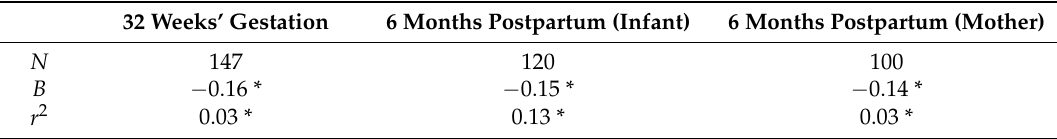
Table 3. Association of the mean salivary cotinine with environmental tobacco smoke (ETS) avoidance (Martinelli Scale) in regression models by timing of measure. 32 Weeks’